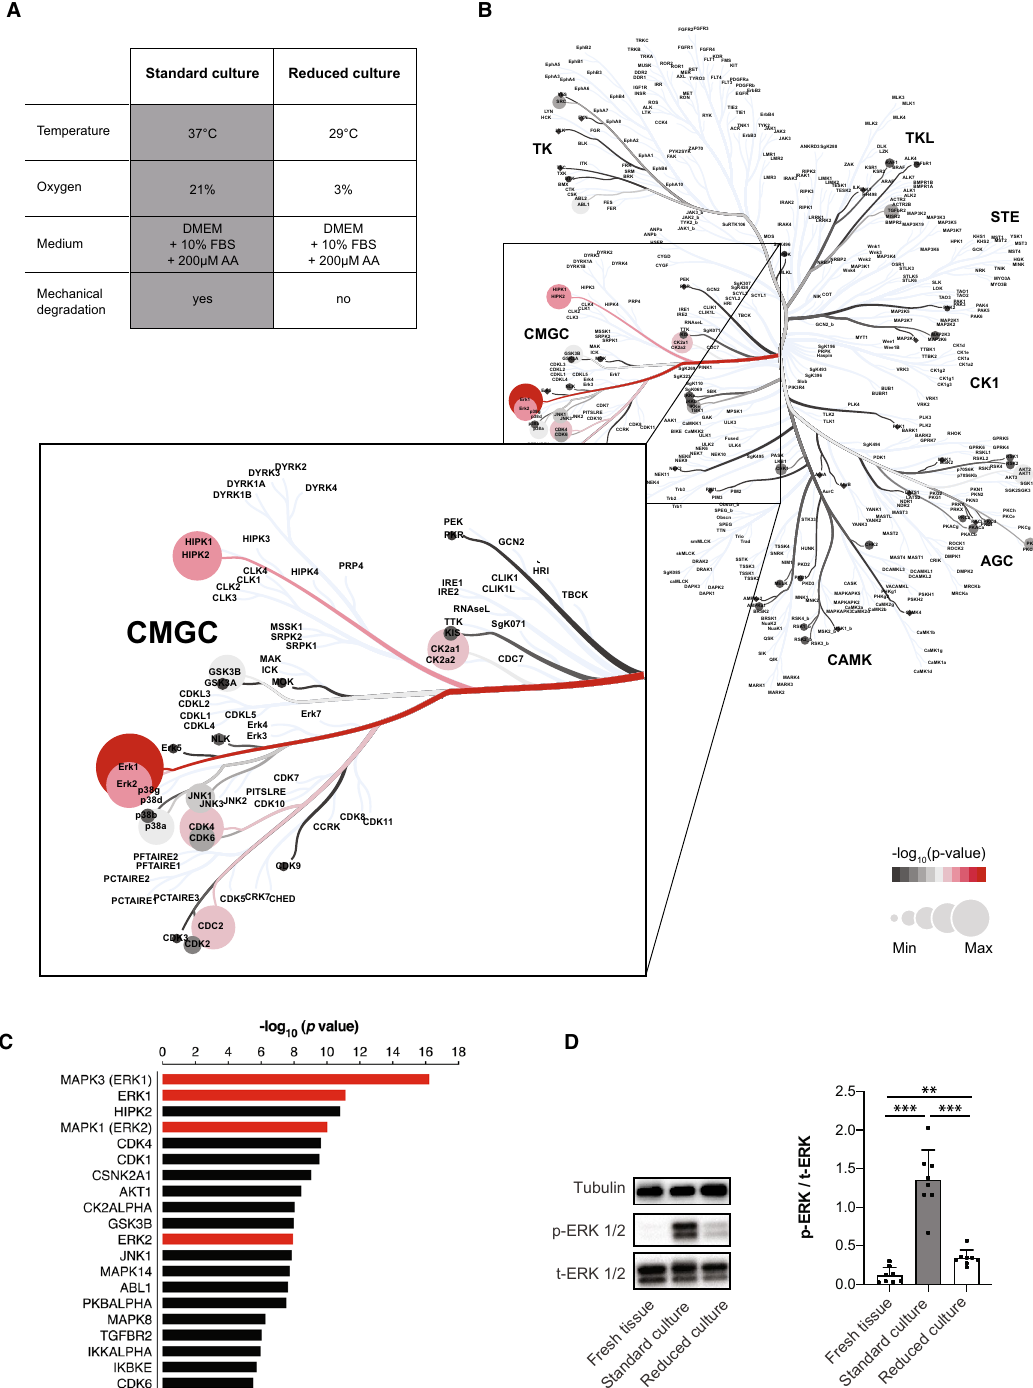
Figure 1. Niche-dependent ERK 1/2 activity and phosphorylation in load-deprived tendon explant cultures. ( A ) Overview of experimental conditions and starting phenotypes. DMEM = Dulbecco’s modified Eagle’s medium, FBS = fetal bovine serum, AA = ascorbic acid. ( B ) Upstream kinase enrichment prediction based on the transcriptome data set E-MTAB-7832 (ArrayExpress), which analyses differentially expressed genes in tendon tissues cultured ex vivo in standard and reduced niches. Kinome tree dendrogram mapping of all the predicted protein kinases generated by Coral 42 . The circle color and size reflect the enrichment significance with red color encoding higher significance. ( C ) Bar plots show the 20 most significantly enriched kinases. Red bars represent the ERK 1 and 2 kinases. GraphPad Prism (version 8.4.3) was used to generate the figure. ( D ) Western blot validation of ERK 1/2 phosphorylation (ERK 1: Thr202/Tyr204; ERK 2: Thr185/Tyr187) in freshly isolated or cultured tendon fascicles (12 days). Full Western blot images are provided in the supplementary material (Supplementary Fig. 3). Quantification of band pixel intensities of phosphorylated ERK (p-ERK 1/2) compared to the total ERK (t-ERK). GraphPad Prism (version 8.4.3) was used to perform statistical analyses and generate the figure. Bars show mean values + SD, with individual replicate values as data points, N = 8. Repeated measure ANOVA with Tukey’s multiple comparisons test: ** p < 0.01, *** p <